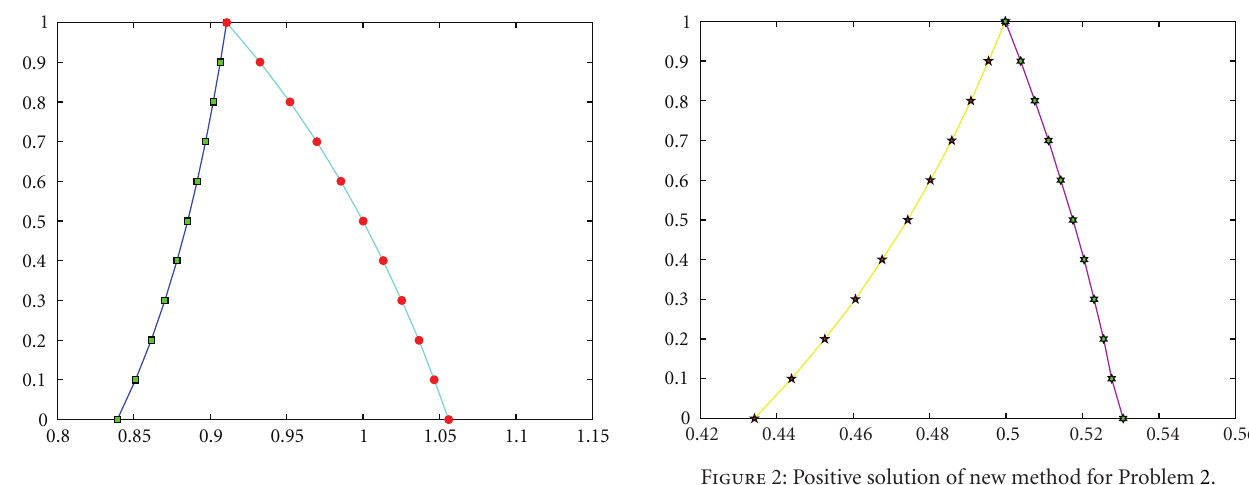
Figure 2: Positive solution of new method for Problem 2.